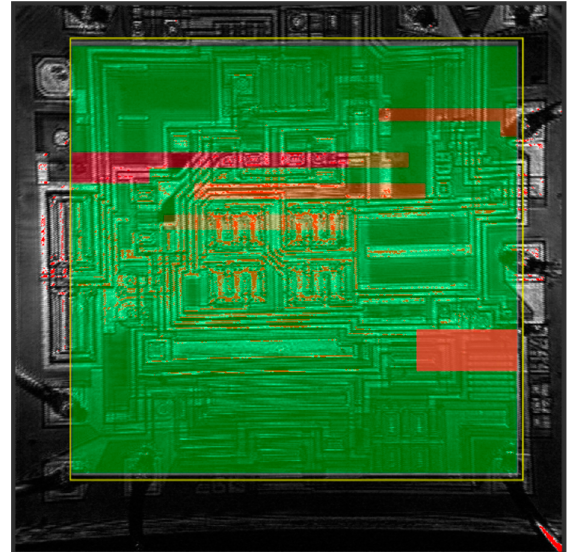
Figure 16. Sensitive map for AD711 amplifier (laser energy: 4 nJ).